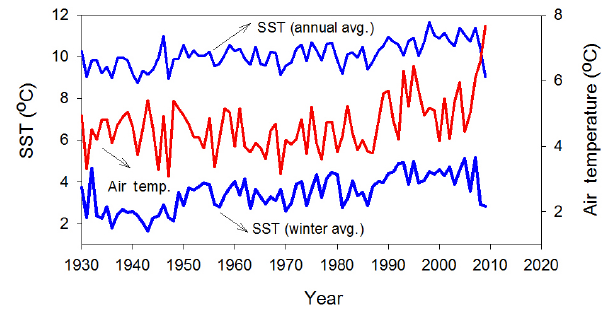
Figure 7. The variability of annual mean air temperature near Vladivostok (red line), and the annual mean sea surface temperature (SST) and winter (December to February) mean SST (blue line) in the Japan Basin of the East/Japan Sea from 1932 to